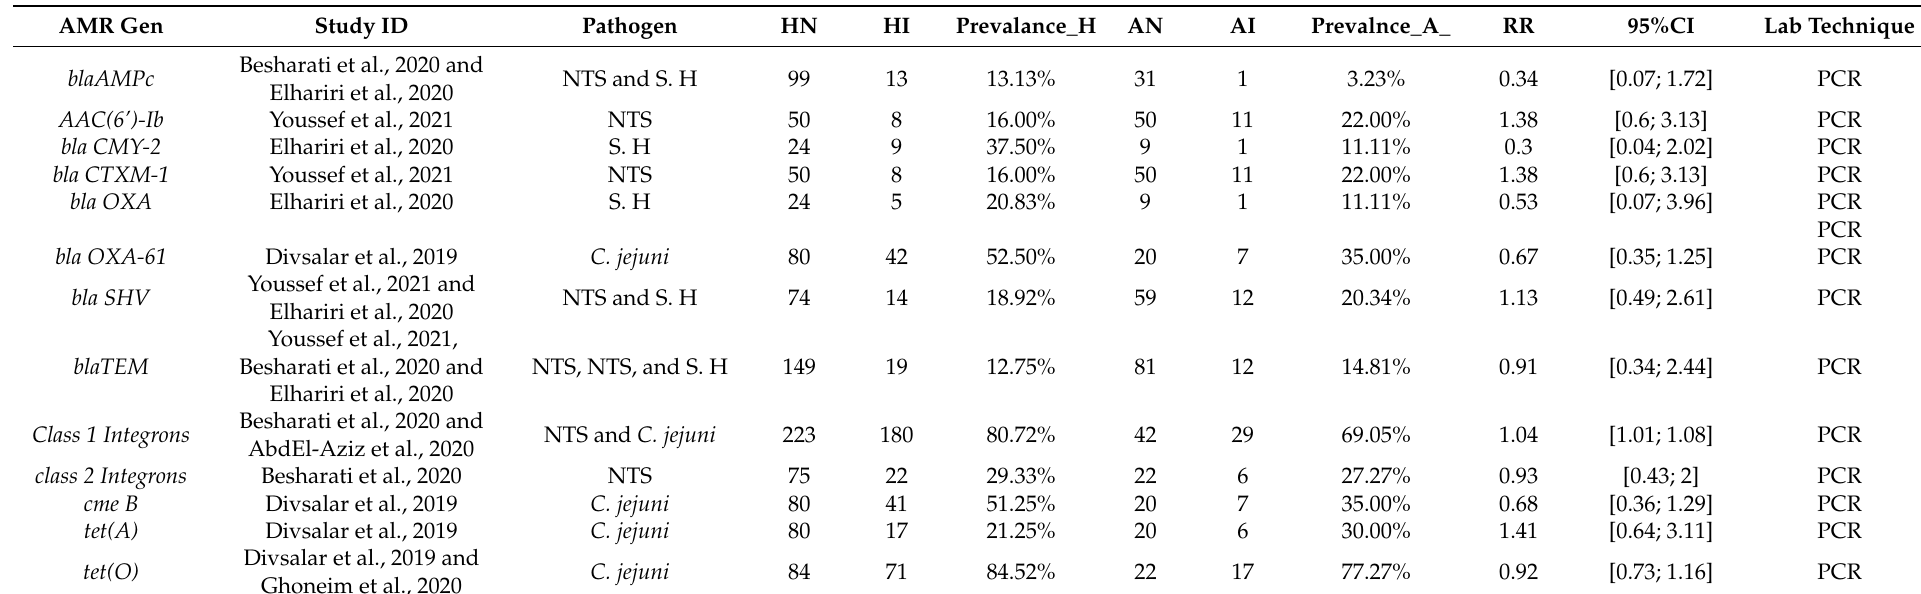
Table 5. Prevalence of AMR genes found in non-typhoidal Salmonella spp. and Campylobacter jejuni